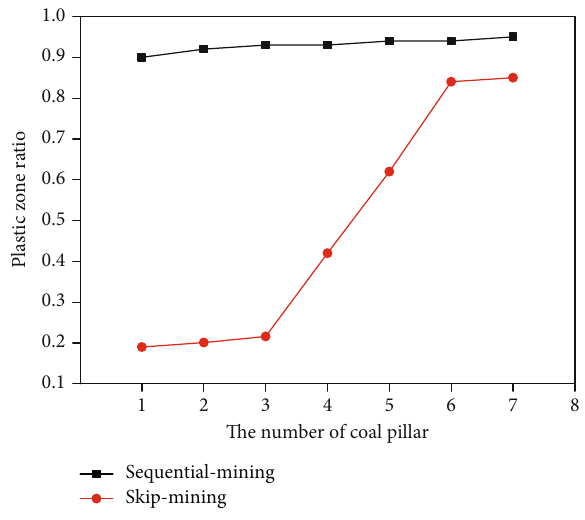
Figure 11: The curves of plastic zone